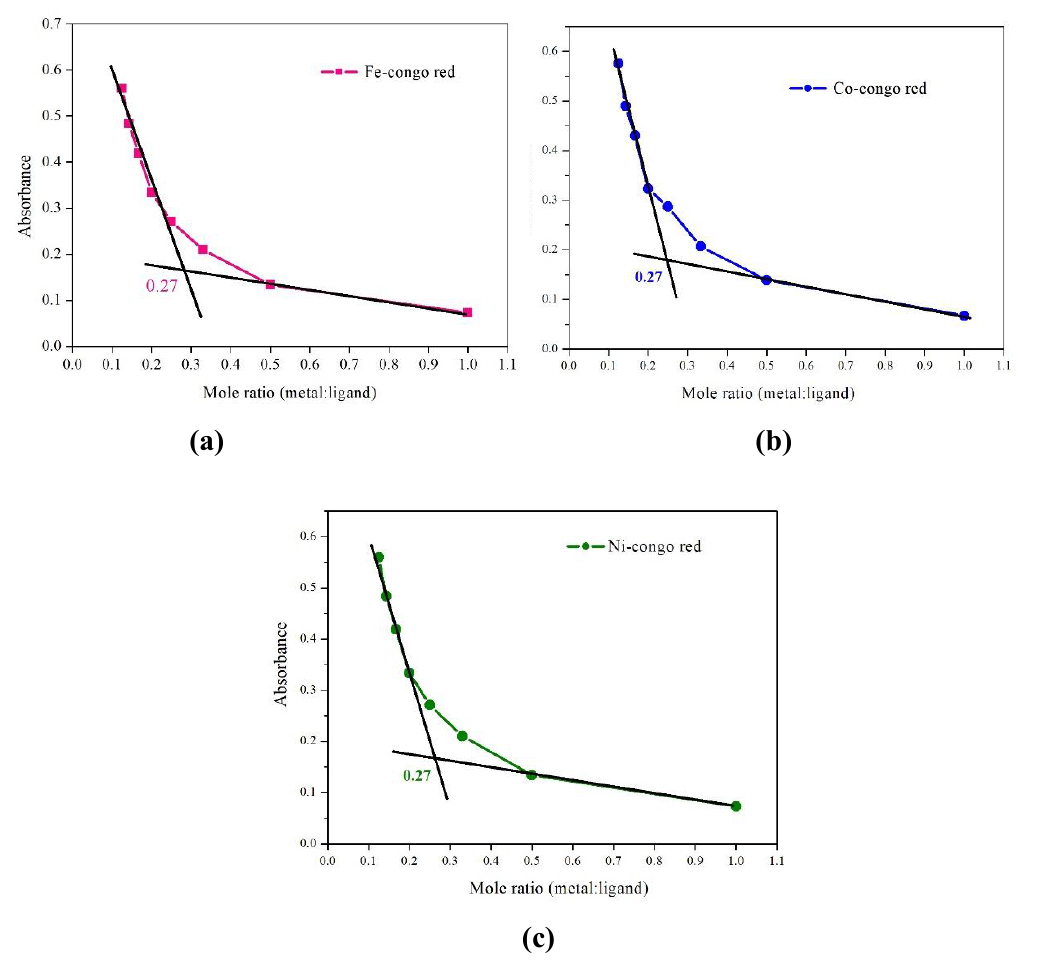
Figure 2: The determination of mole ratio of metal to ligand for the congo red complexes.